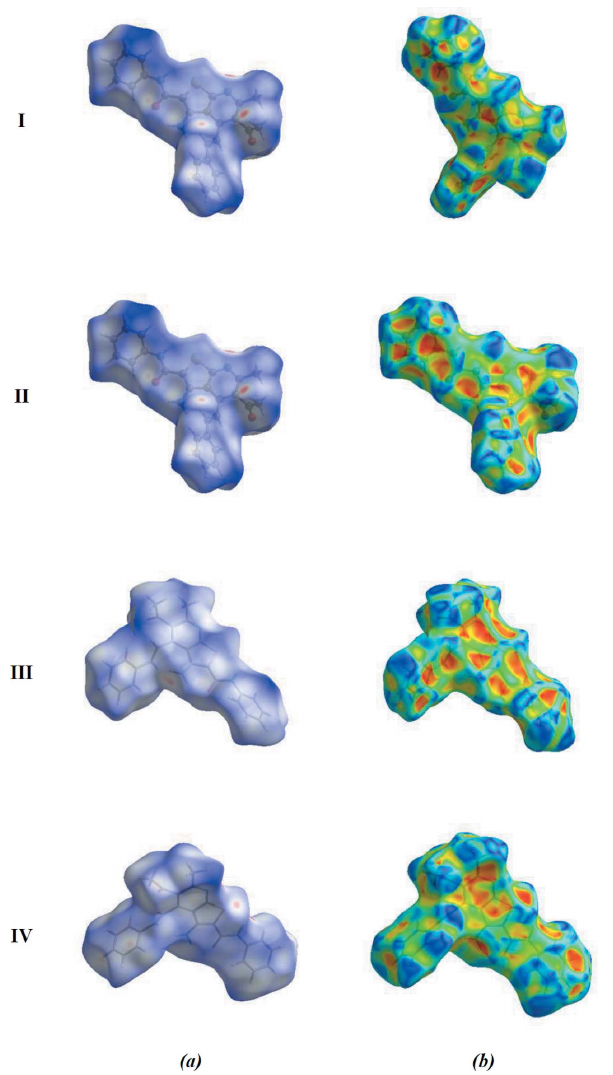
Figure 6 Aview of the three-dimensional Hirshfeld surface for the four molecules (I, II, III and IV) in the asymmetric unit of the title compound, plotted over ( a ) d norm and ( b )